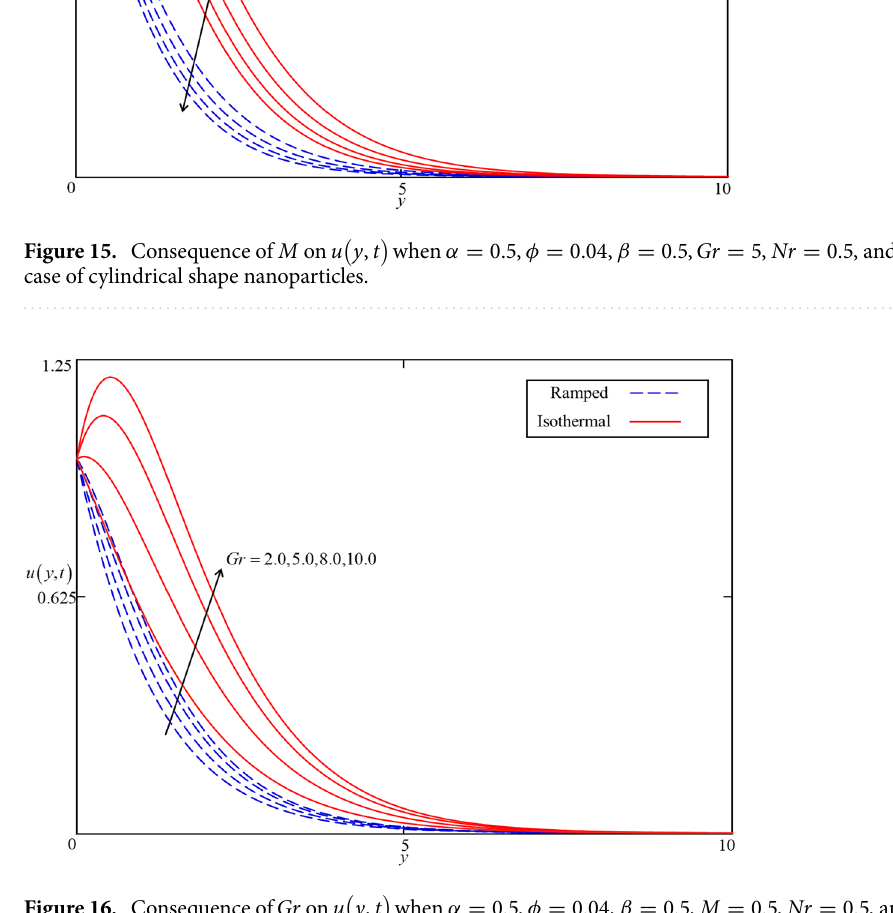
Figure 16. Consequence of Gr on u for spherical s